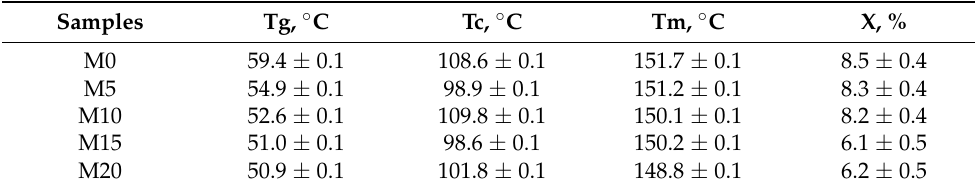
Figure 1. The samples’ differential scanning calorimetry (DSC) thermograms. Table 1. The samples’ thermal